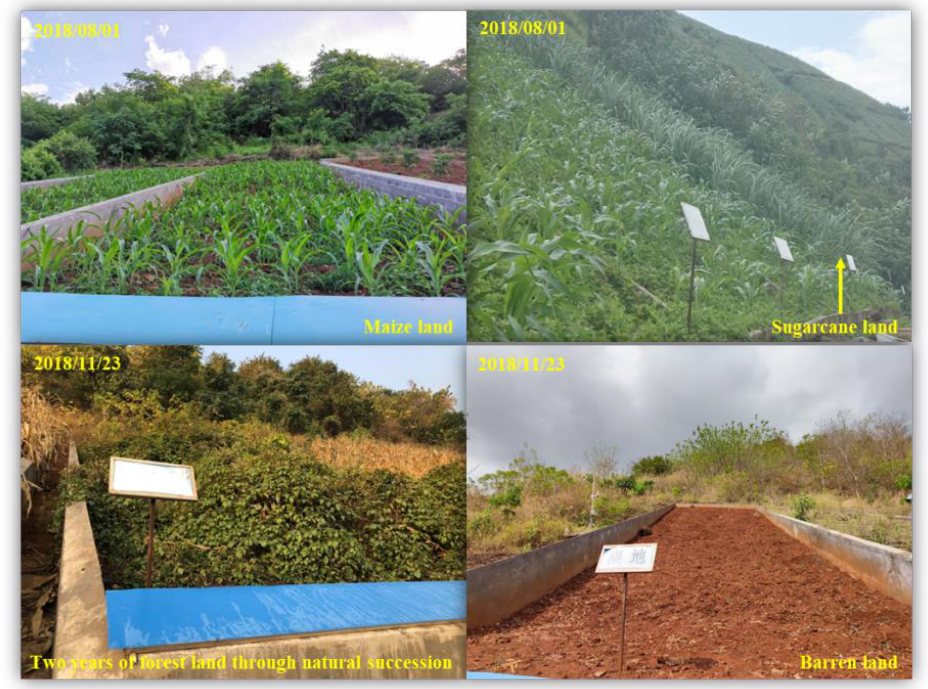
Figure 1. The experimental plots of four land-use types.